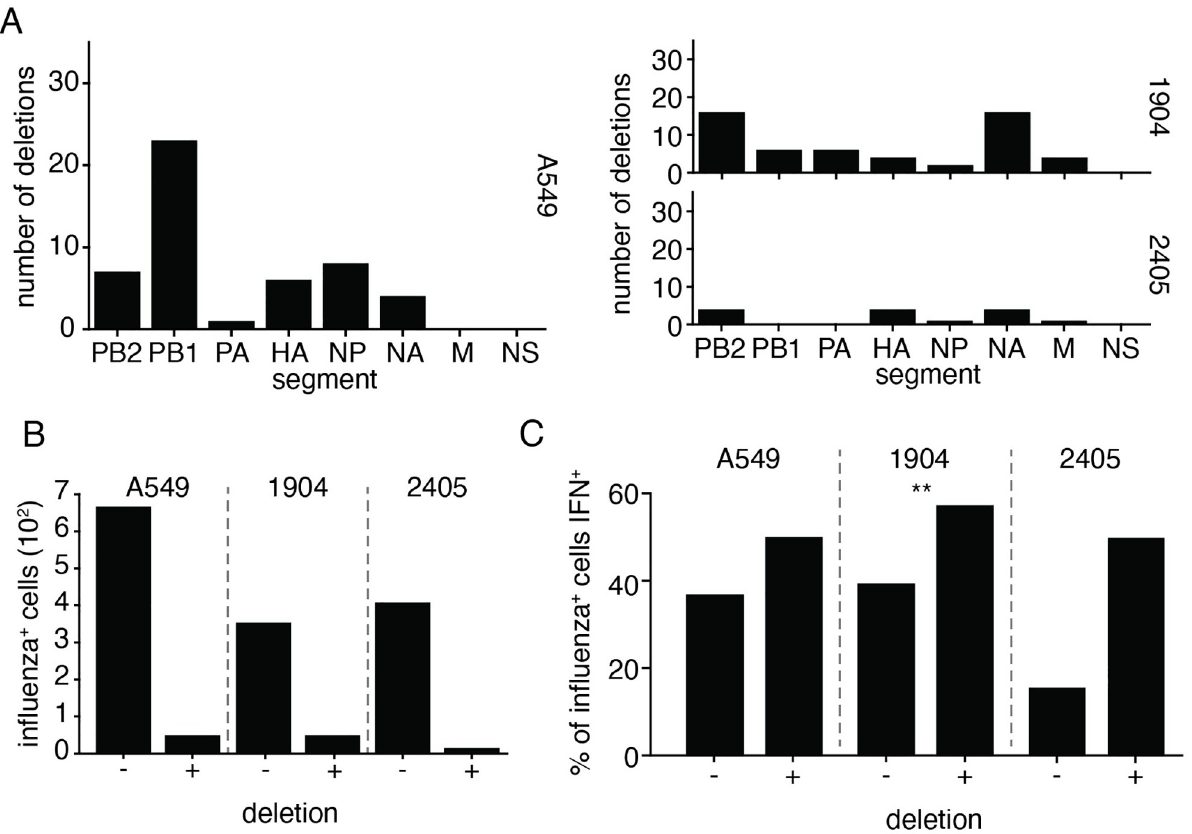
Fig 3. Deletions associate weakly with interferon induction in NS1-impaired single-cell data. (A) Number of unique cell/deletion combinations observed for each segment across each single-cell dataset. Thresholds for deletion identification presented in S3, S5 and S7 Figs. (B) Frequencies of deletion detection across influenza-infected cells in each single-cell experiment. (C) Fraction of cells with, and without, detectible deletions identified as interferon-positive, considering only infections with a greater fraction of influenza transcripts than the median value observed in infections in which deletions were confidently identified. While all populations trended in the same direction, only one population was found to have significant co- occurrence of deletions and interferon production, Fisher’s exact test (p < 0.05). The lack of significance in 2405 is likely in part due to the small number of sampled